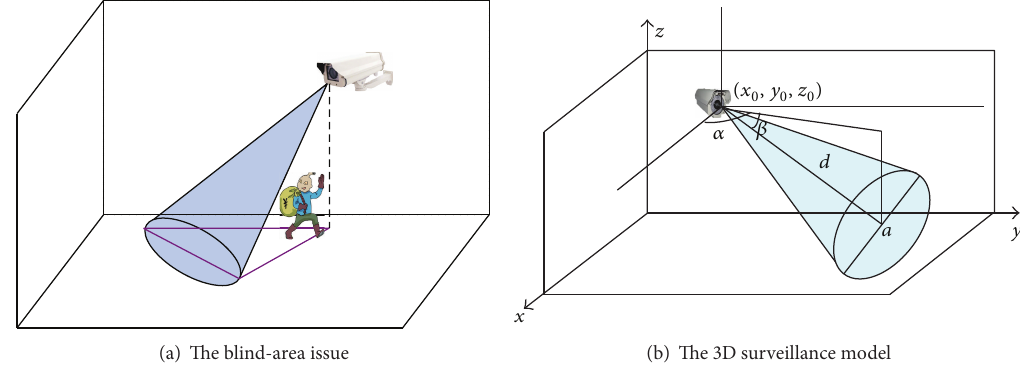
Figure 3: An instance of blind-area issue caused by 2D model and the 3D surveillance model of